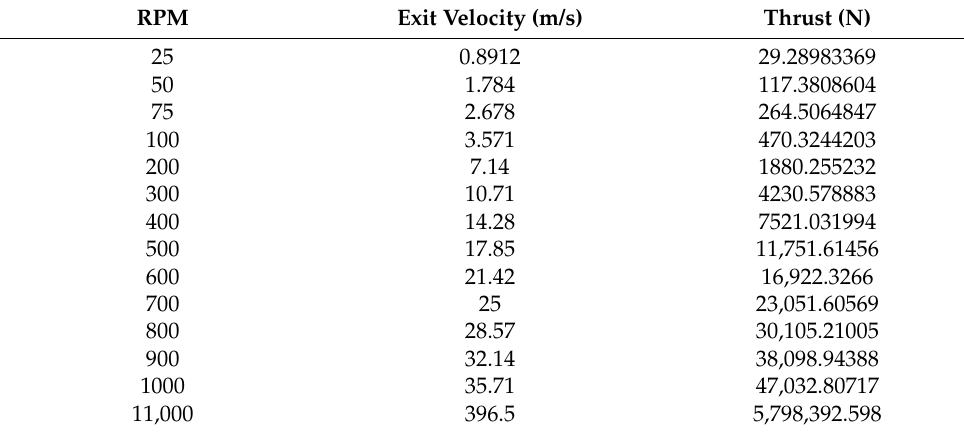
Figure 21. Velocity variations of 11,000 RPM. The total thrust outputs for various RPMs of the US propeller are listed in Table 2. Table 2. Thrust calculation from the exit velocity for different RPM of US’s propeller.